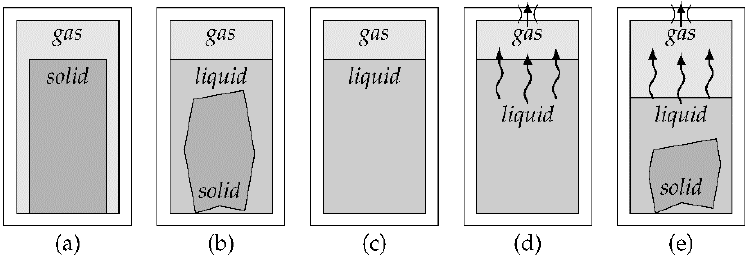
Figure 3. States ( a − e ) of the phase transition process of carbon dioxide inside a closed container, based on [18]; the explanations of the individual states are given in the text.